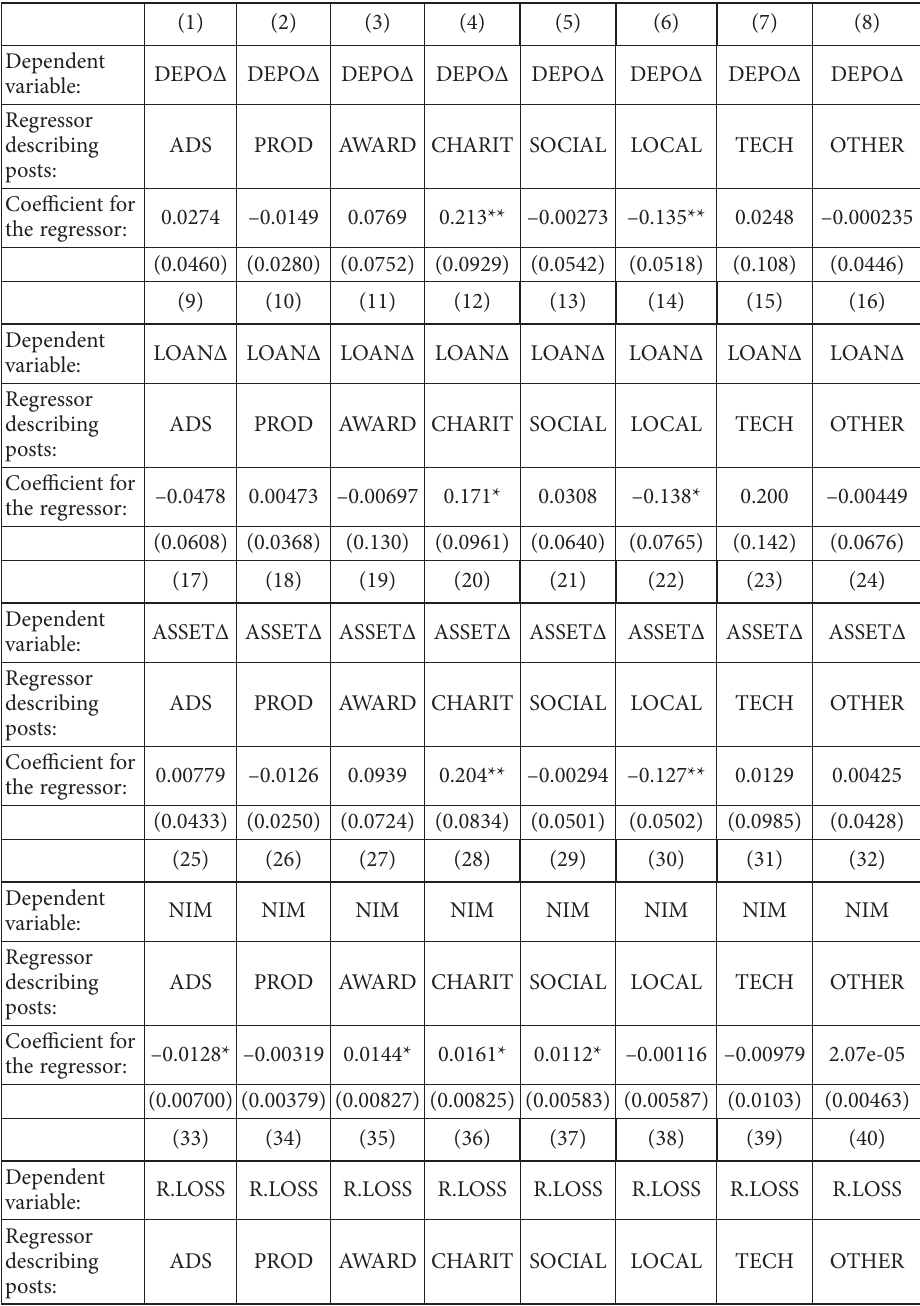
Table 7. Relationships between the content of SLBs’ Facebook posts and bank growth/performance (source: author’s own